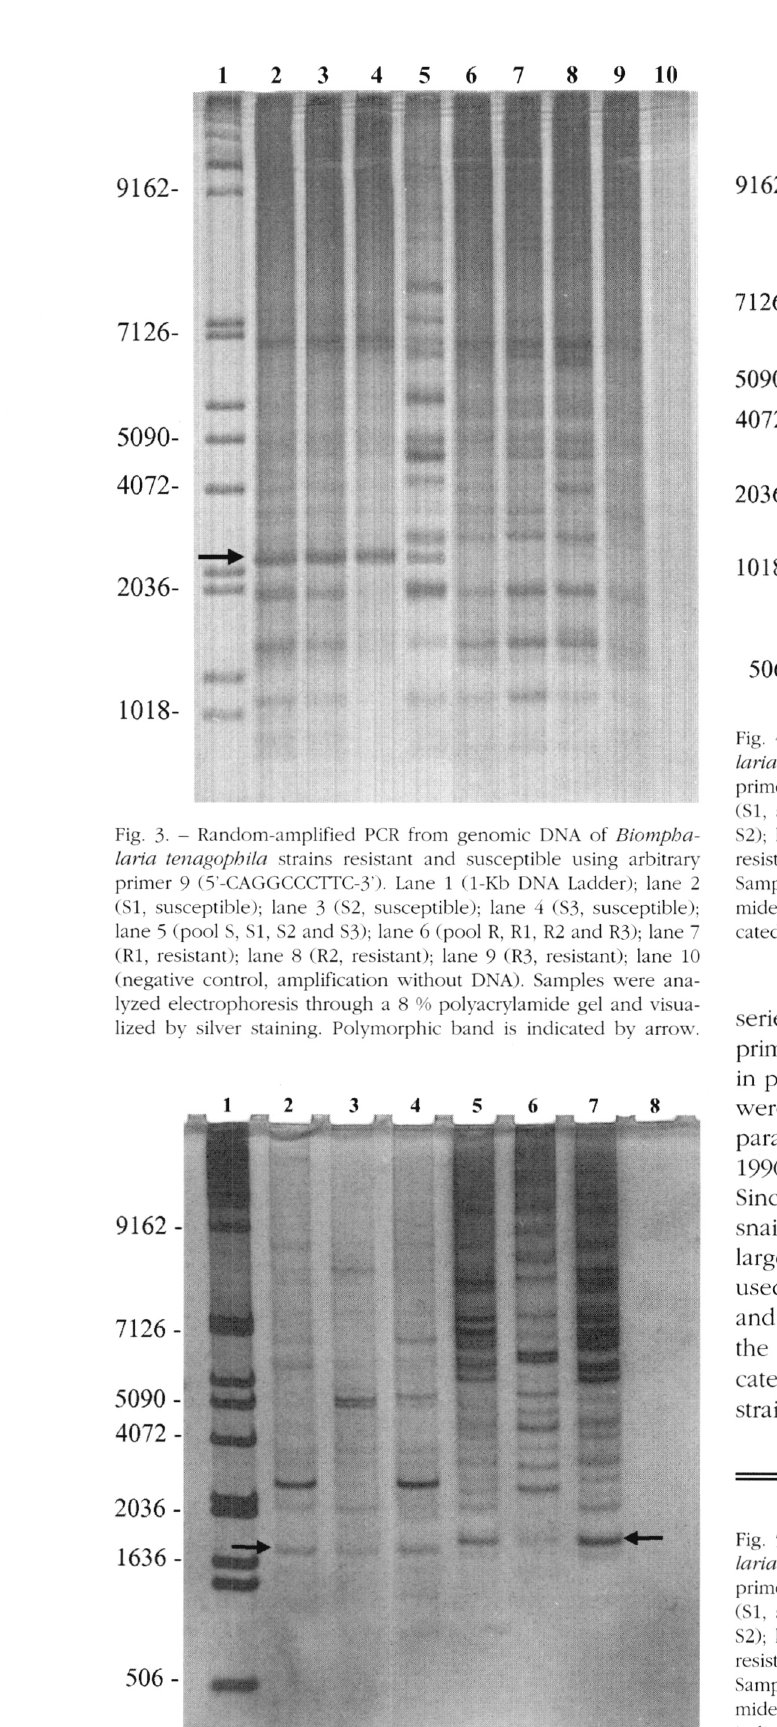
Fig. 5. - Random-amplified PCR from genomic DNA of Biompha­ laria tenagophila strains resistant and susceptible using arbitrary primer 15 (5’-TGCCGAGCTG-3’). Lane 1 (1-Kb DNA ladder); lane 2 (S1, susceptible); lane 3 (S2, susceptible); lane 4 (pool S, S1 and, S2); lane 5 (pool R, R1 and R2); lane 6 (R1, resistant); lane 7 (R2, resistant) and lane 8 (negative control, amplification without DNA). Samples were analyzed electrophoresis through a 8 % polyacryla­ mide gel and visualized by silver staining. Polymorphic bands are indicated by